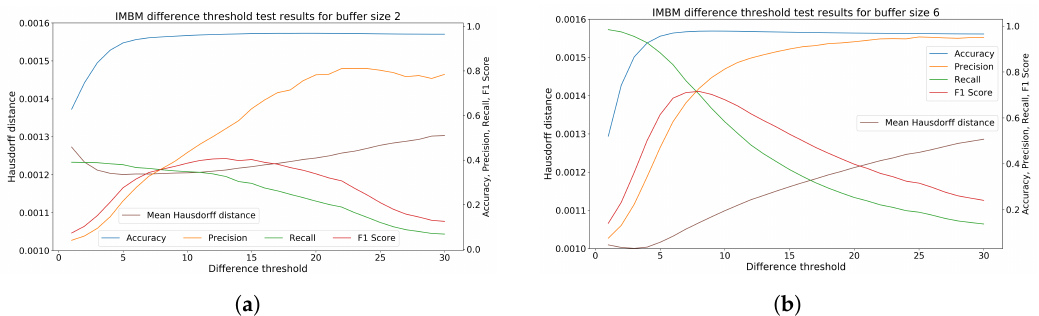
Figure 13. The selection of ideal difference threshold. ( a ) Analysis for buffer size 2. ( b ) Analysis for buffer size